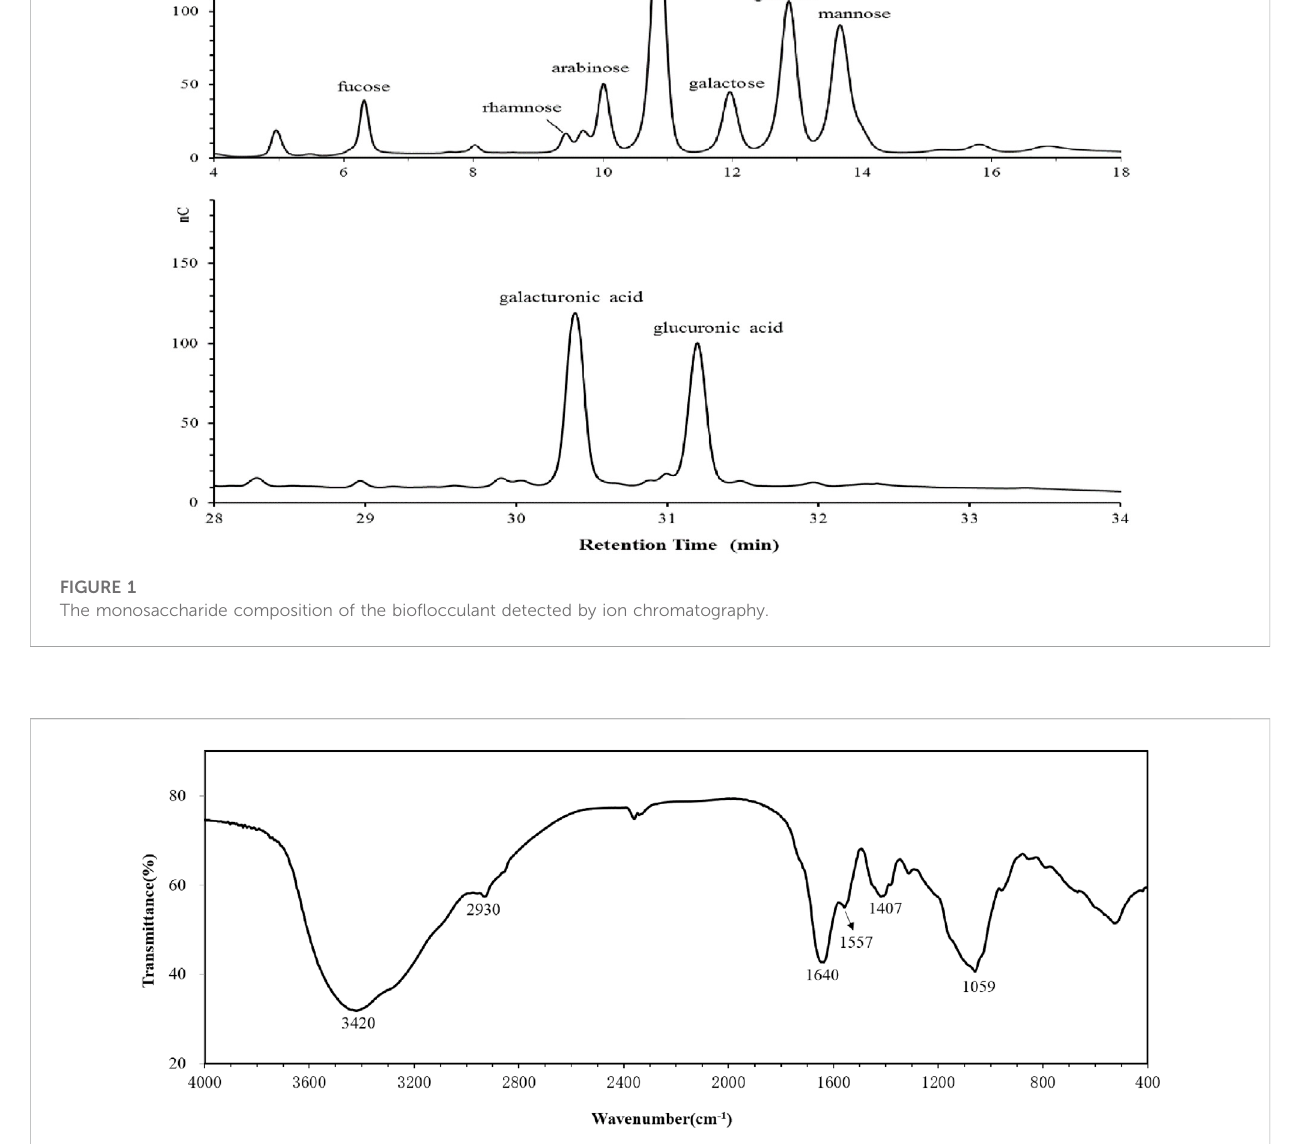
FIGURE 2 FT-IR spectra for the bio fl